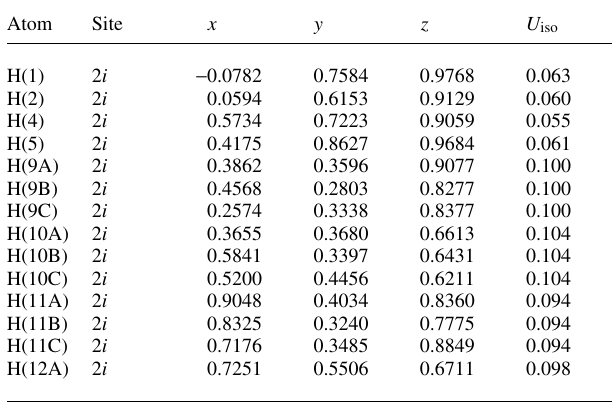
Table 2. Atomic coordinates and displacement parameters (in Å 2 )